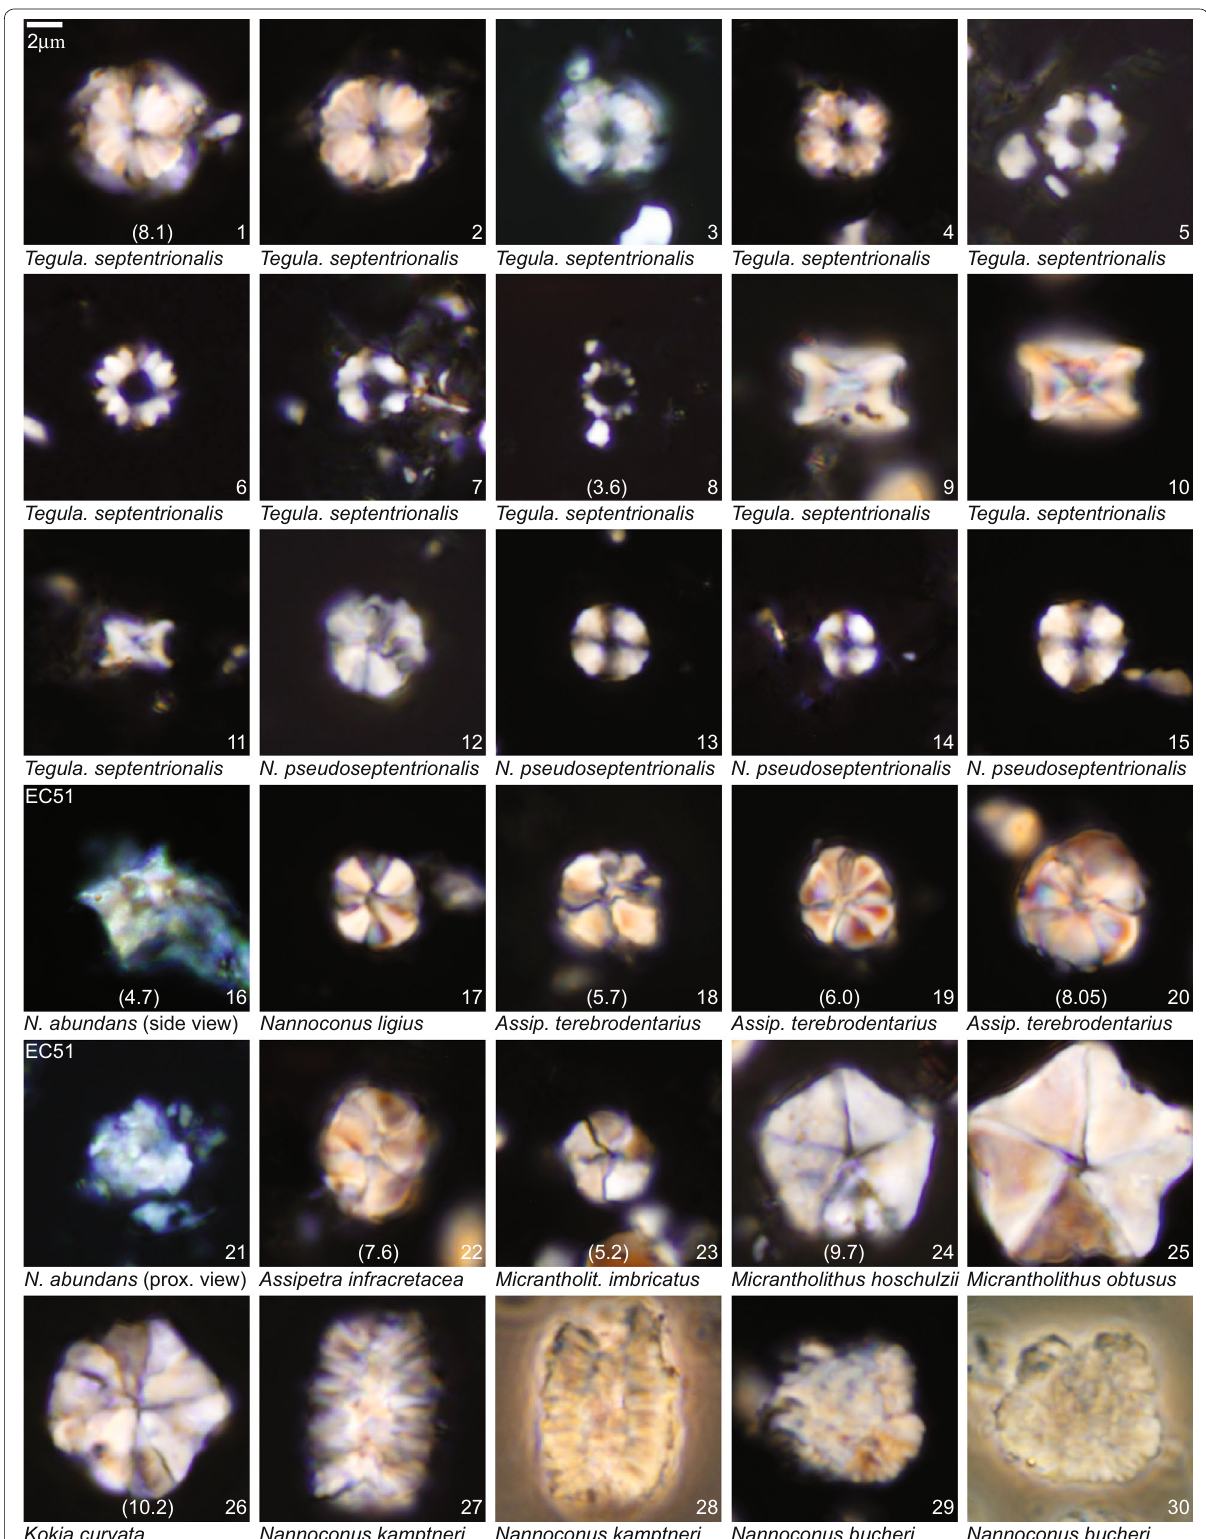
Fig. 7 Calcareous nannofossils from the Marnes de la Russille (Barremian) of the Swiss Jura Mountains. All LM pictures from La Sarraz–Les Buis quarry (without sample numbers: LSBMRu1) and Eclépens quarry (with sample numbers: